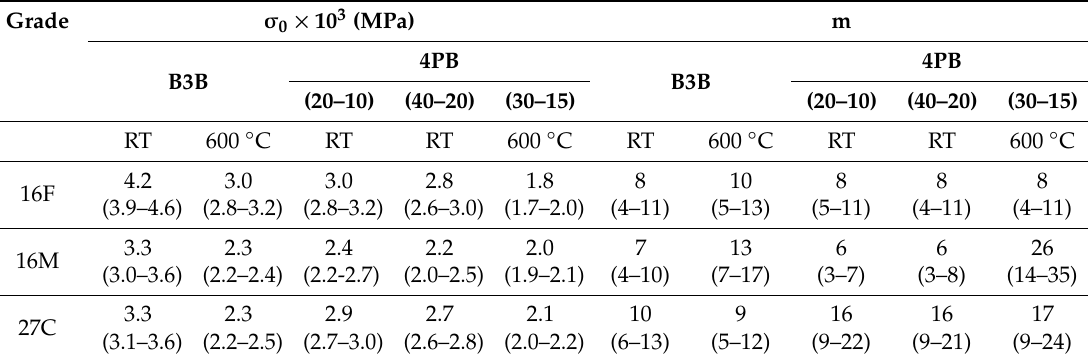
Table 2. Weibull parameters estimated under B3B and P4B tests for the three cemented carbide grades (16F, 16M, and 27C) at room temperature (RT) and 600 ◦